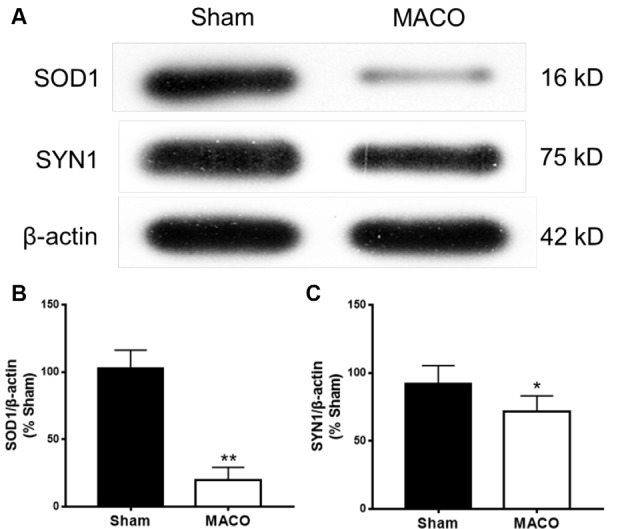
Expressions of SOD1 and SYN1 from brain tissues were examined by Western blotting. (A) Typical images of SOD1 and SYN1 proteins. (B) The statistical quantification showed that MACO significantly decreased the SOD1 level. (C) The statistical quantification showed that MACO significantly decreased the SYN1 level. *p < 0.05 and **p < 0.01 compared to the sham group.